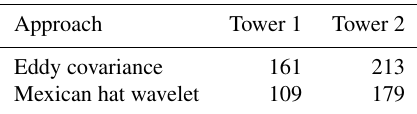
Table 1. Mean flux rates during the 30min period that hosted the peak event discussed in the case study, as detected by two dif- ferent flux processing approaches. All flux values are given in nmolm − 2 s − 1